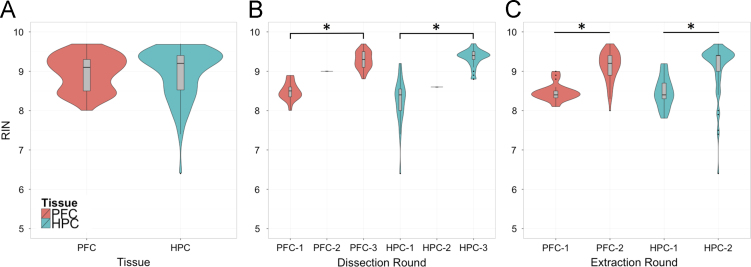
RNA integrity numbers (RIN) differ between extraction and dissection rounds. (A) No difference in average RIN was identified between samples from the prefrontal cortex (PFC) and the hippocampus (HPC). (B) Significant effects of tissue dissection round were identified between round 1 and round 3 in both tissues. Dissection round 2 contained a single sample in both tissues and was not included in statistical analysis. (C) Significant effects of RNA extraction round were also observed in both tissues. ⁎Denotes statistical significance below p<0.00001 by Welch׳s t-test.